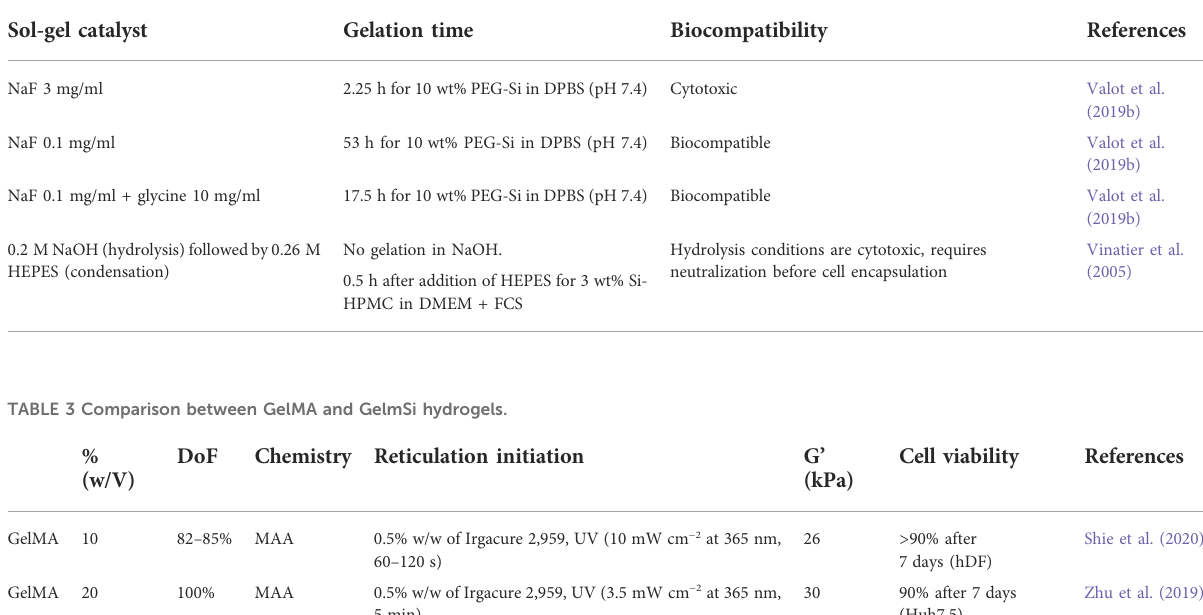
TABLE 2 Examples of sol-gel catalysts.